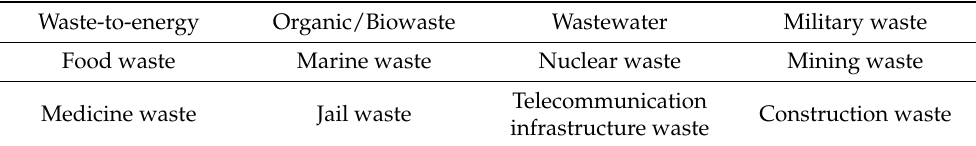
Table 3. Examples of words that were not in the core focus of this study (consumable e-waste) and not considered in the screening phase of SLR.